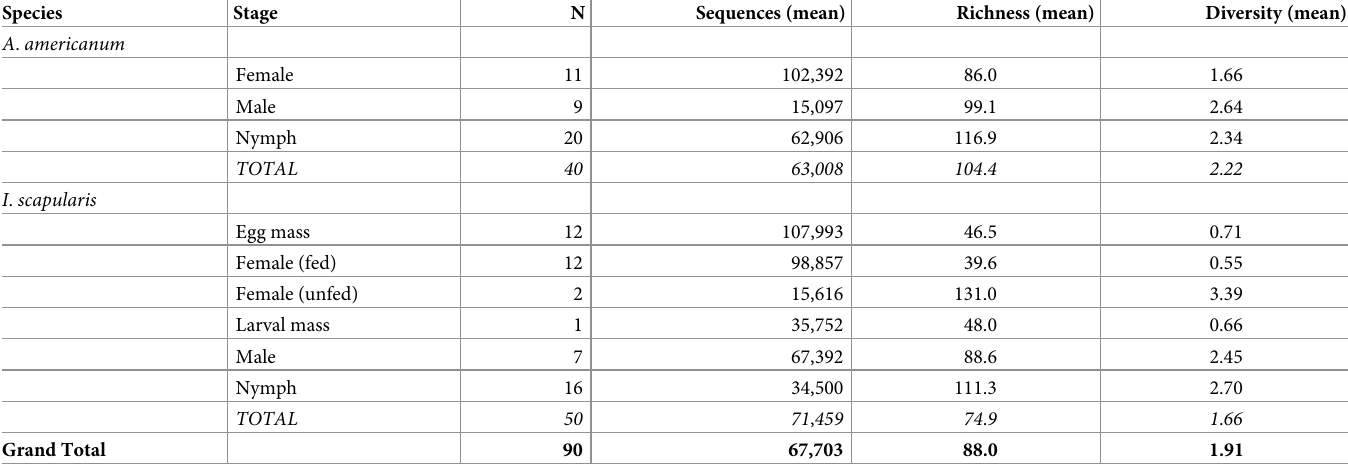
Table 1. Sample size, average sequencing depth, OTU richness and OTU diversity for each life stage and each tick